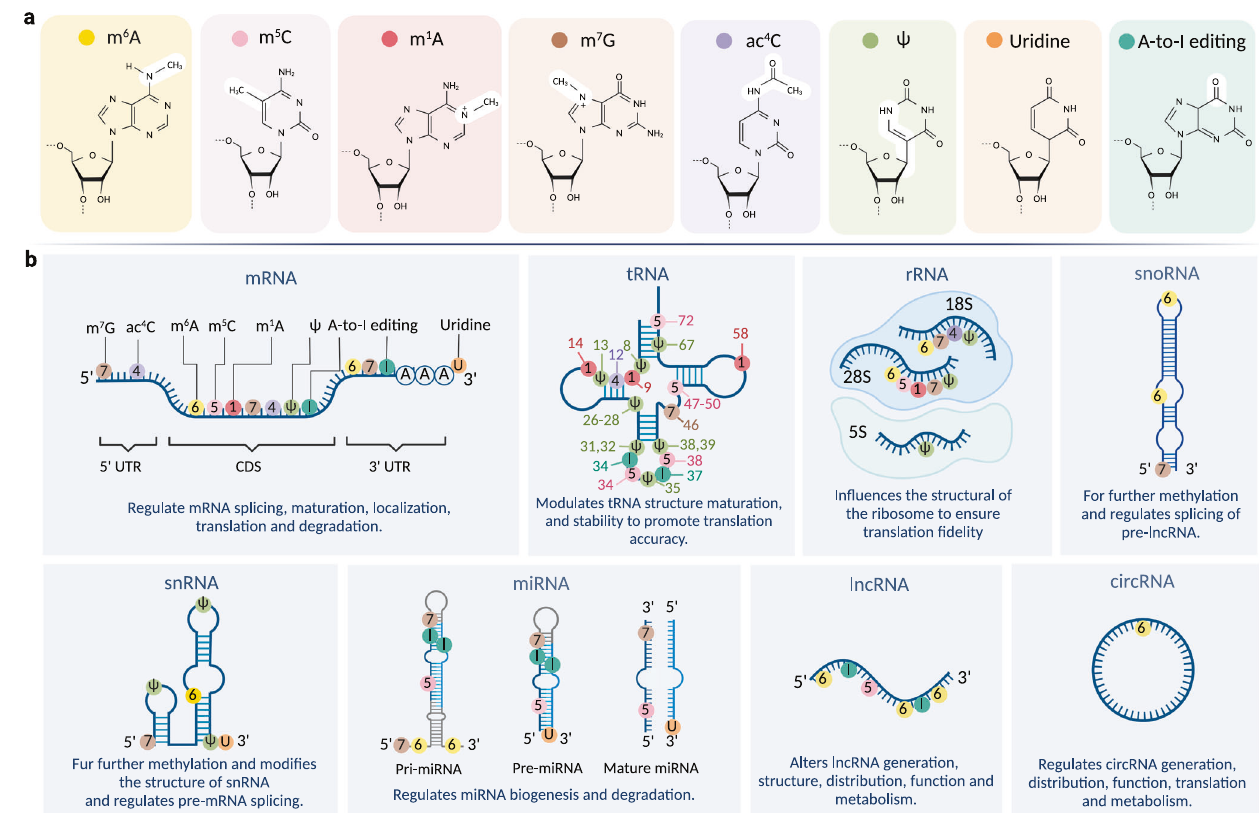
Fig. 1 RNA modi fi cations and their distributions on different RNA subtypes. a Chemical structures of eight RNA modi fi cations. b Distribution of RNA modi fi cations on different RNA subtypes. Indicated modi fi cations are labeled at the corresponding modi fi cation sites. m 6 A N 6 - methyladenosine, m 5 C 5-methylcytosine, m 1 A N 1 -methyladenosine, m 7 G 7-methylguanosine, ac 4 C N 4 -acetylcytidine, ψ pseudouridine, A-to-I editing adenosine-to-inosine RNA editing, CDS coding sequence, UTR untranslated regions, pri-miRNA primary microRNA,